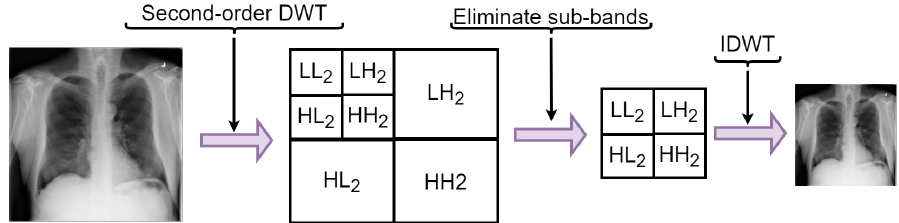
Figure 6. Illustration of discrete wavelet transform operation for